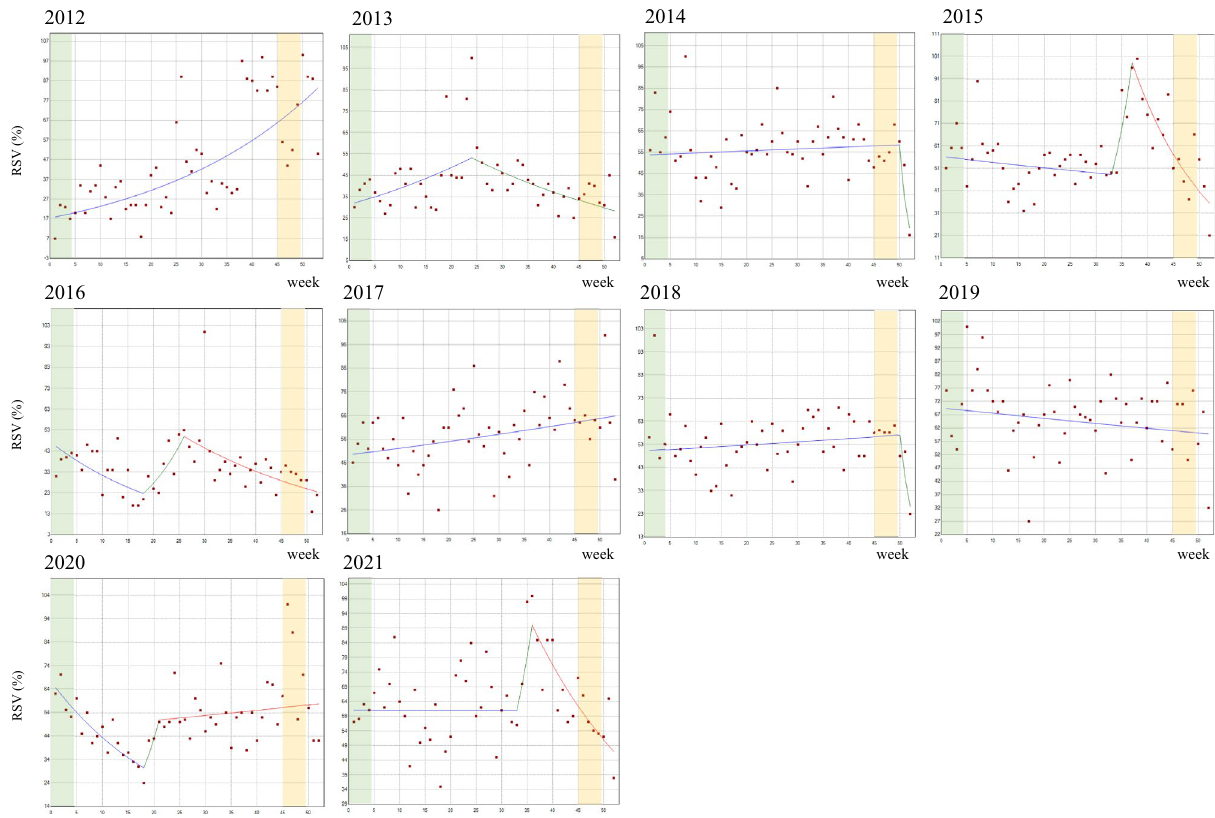
Figure 4. Weekly trend change analysis of relative search volumes in Google Trends by joinpoint regression in the “Health” category by year from 2012 to 2021. The cervical cancer awareness month (CCAM) is depicted in green (week 1–4). The cervical cancer prevention awareness enhancement month (CCPAEM) is highlighted in yellow (week 45–48). Joinpoints are the time points at which statistically significant changes ( p < 0.05) in the linear slopes were noted. Detailed data are presented in Table 3.